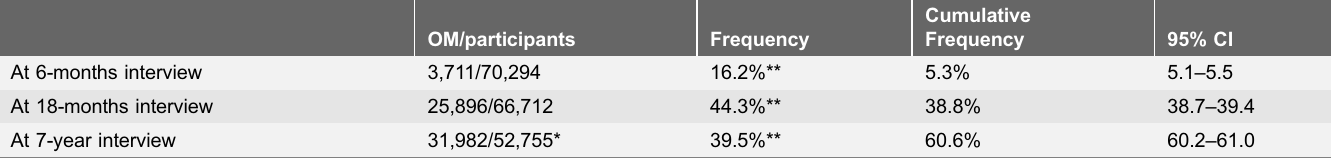
Table 2. Frequency of otitis media (OM) among children aged 0–7 years of age in the Danish National Birth Cohort, 1996–2005,